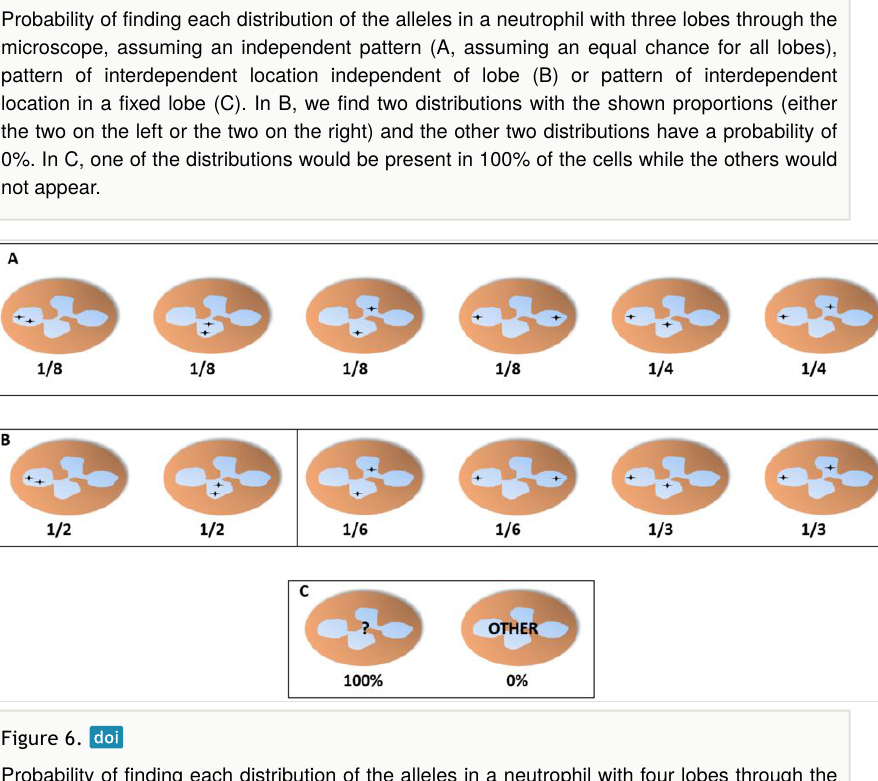
Probability of fi nding each distribution of the alleles in a neutrophil with four lobes through the microscope, assuming an independent pattern (A, assuming an equal chance for all lobes), pattern of interdependent location independent of lobe (B) or pattern of interdependent location in a fi xed lobe (C). In B, we fi nd two distributions with the shown proportions (either the two on the left or the four on the right) and the other distributions have a probability of 0%. In C, one of the distributions would be present in 100% of the cells while the others would not